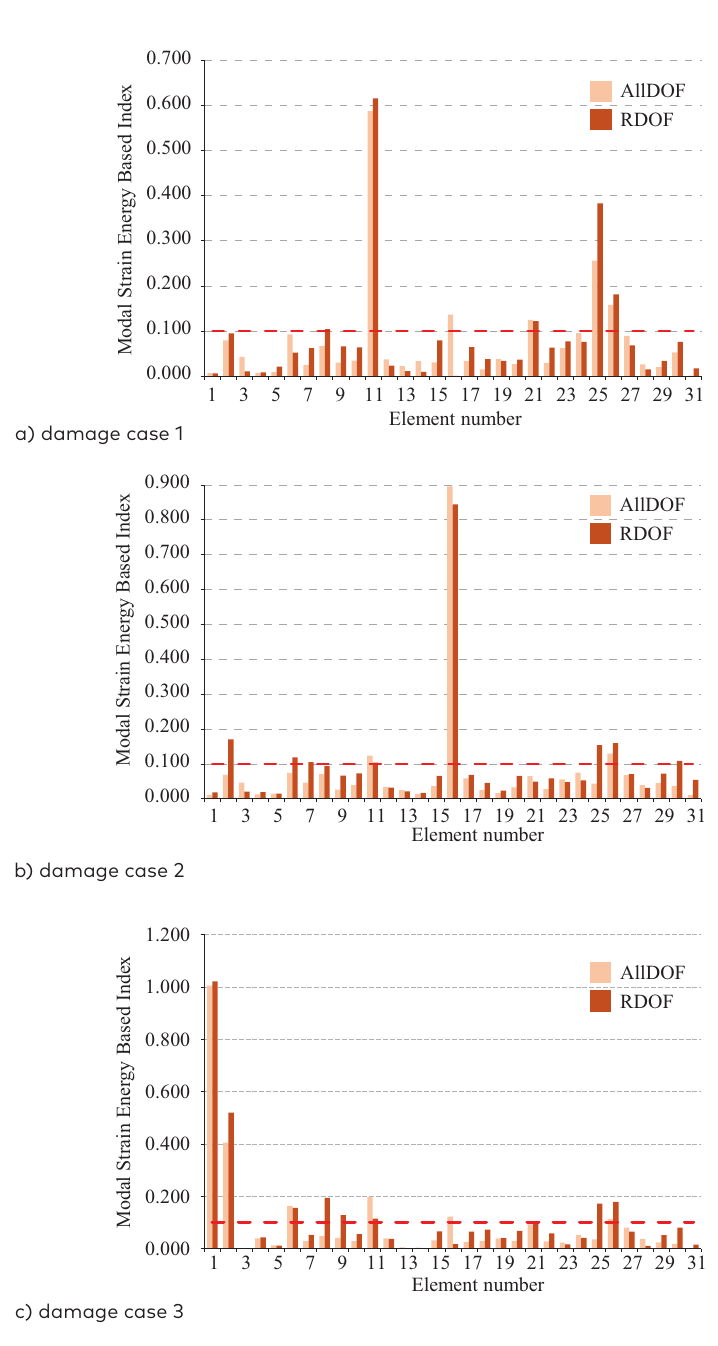
Figure 8. Damage index values in 31-element truss for five modes with 3%